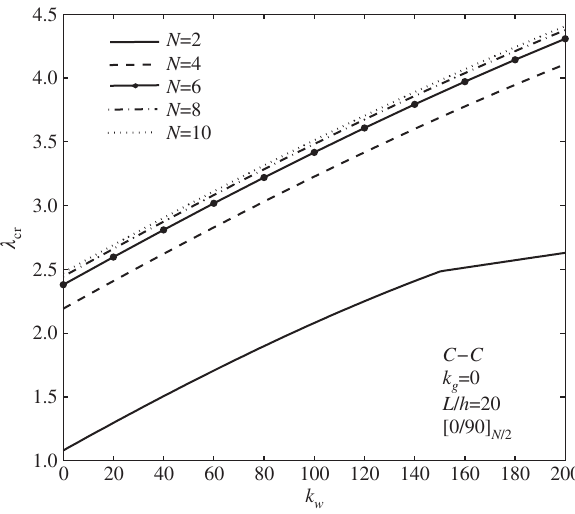
Figure 4 Influence of the number of layers and shear constant of elastic foundation on λ